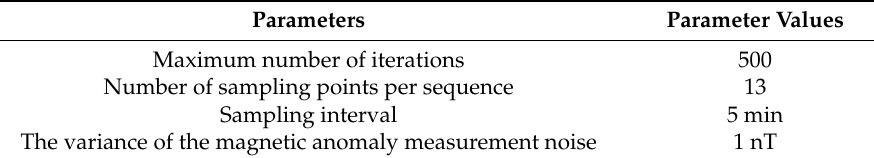
Table 3. Configuration of the vector iterated closest contour point (VICCP) algorithm.